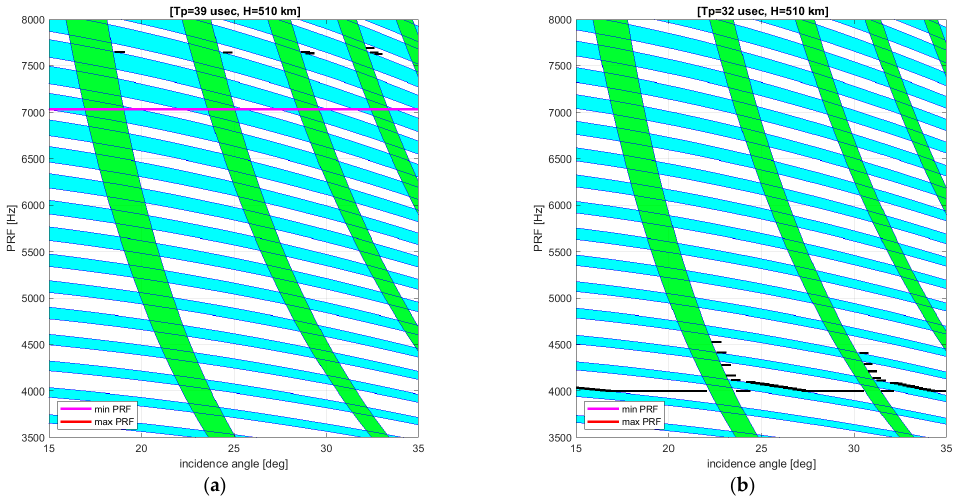
Figure 23. PRF diamond diagrams of the S-STEP SAR payload in the ( a ) high-resolution and ( b ) wide-swath modes.